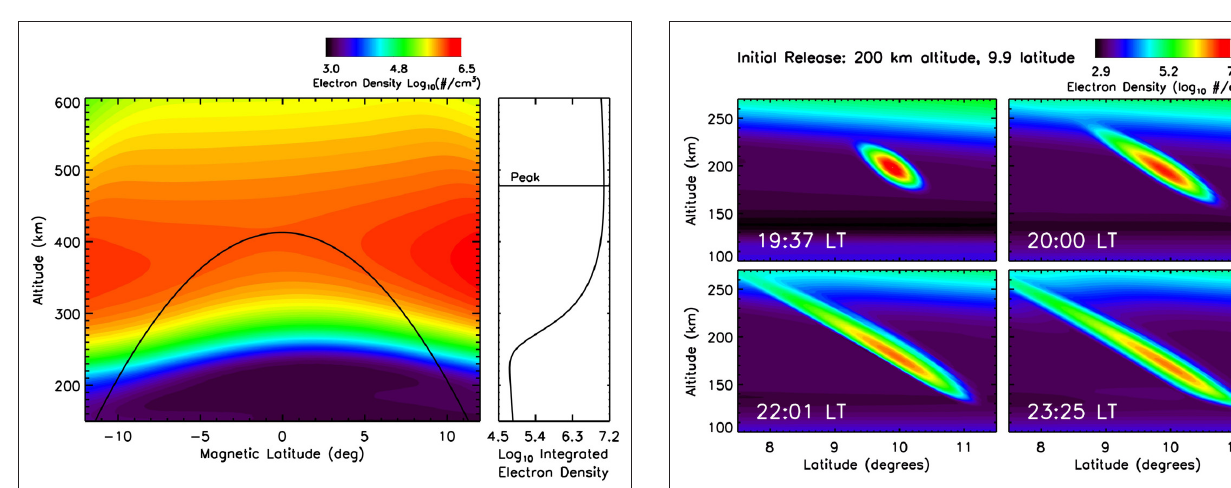
FIGURE 2 | Electron density (log 10 cm − 3 ) as a function of latitude and altitude at four times during the simulation. At 19:30 LT, 5.0 × 10 7 cm − 3 Al + ions are released at 200 km altitude, 9.9 ◦ latitude. The plasma spreads along the field line (as shown in the Top right and Bottom left ), then the structure begins to drift